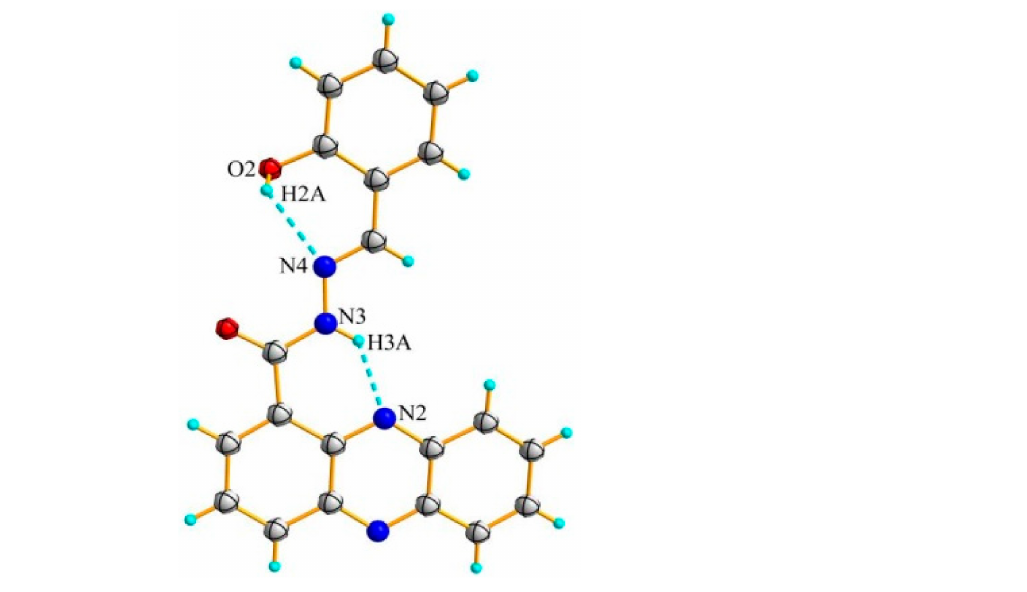
Figure 1. Crystal structure of compound 3b (dotted line represents hydrogen bond). Table 2. Anti-tumor activities of compounds 3a – 3j [IC50/( µ mol/L)].